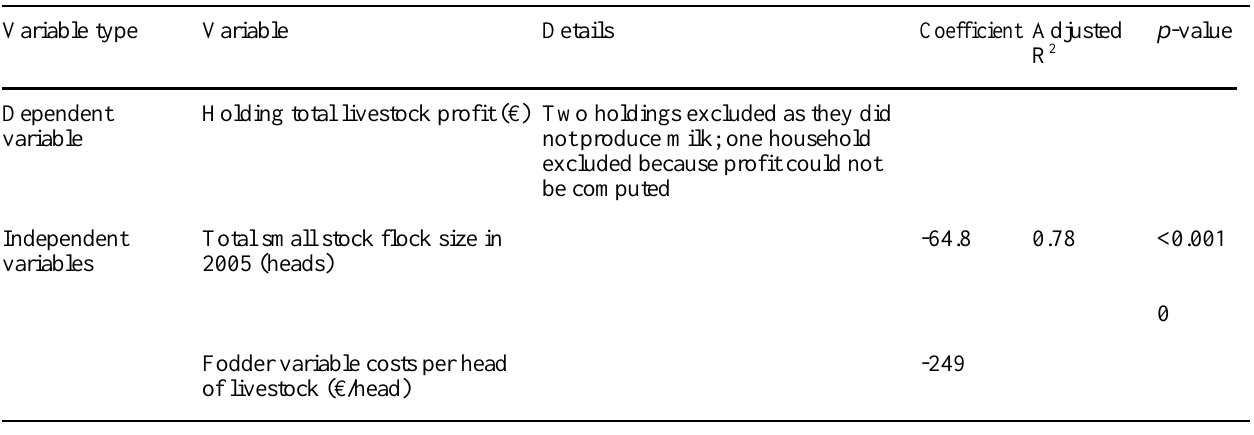
Table 9. Linear regression results for stock-breeding intensification and flock size as explanatory variables for change in livestock profit ( n =